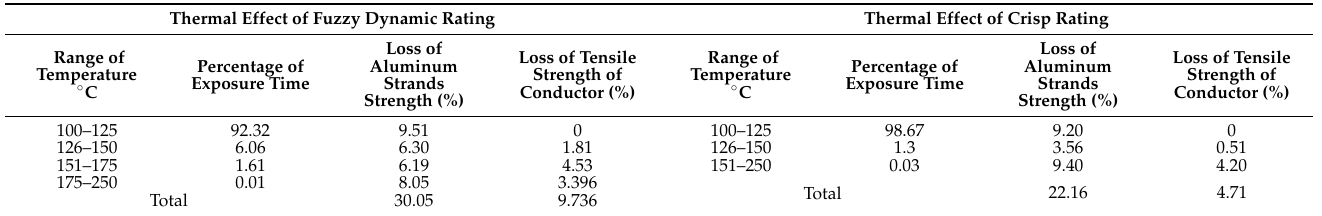
Table 7. Loss of tensile strength in aluminum strands and in the complete conductor over a twenty- year